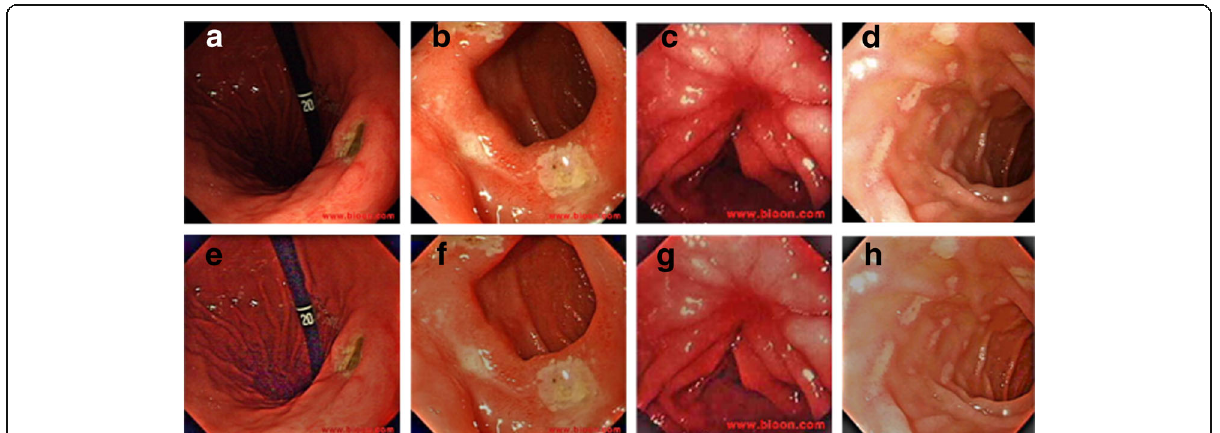
Fig. 5 L 1 L 2 VR results of endoscopic images. a – d Original images. e – h L 1 L 2 VR results of ( a – d